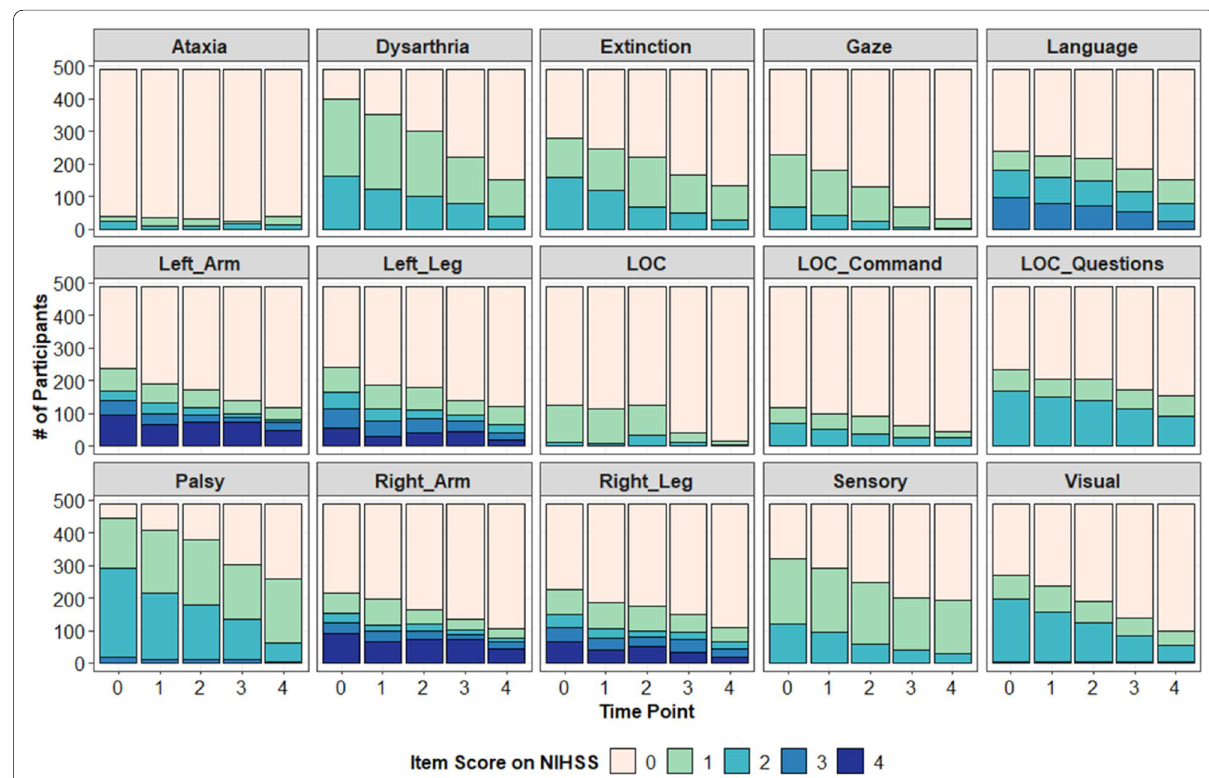
Fig. 1 Data from the NINDS tPA trial shown as a function of time and the 15 NIHSS assessment items. Note that some items (e.g., ataxia) range from 0 to 2, others from 0 to 3 (e.g., language), and others from 0 to 4 (e.g., arm and leg measures). The proportion of participant obtaining that score at each timepoint is shown via a color-coded stacked histogram (total N =